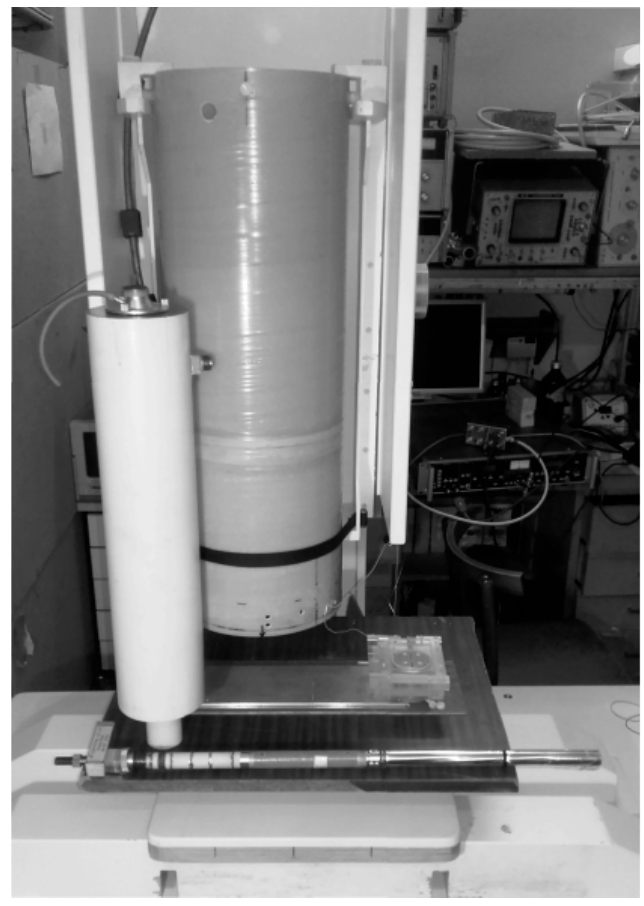
Figure 5. Photograph of a single-channel low-T c DC SQUID-based gradiometer system with a liquid He cryostat and a measurement probe. The first-order gradiometer was made of insulated Nb wire with a diameter of 0.05 mm using a “1:1” configuration (one lower and one upper turn) on a textolite rod. The diameter of the pick-up loops of the gradiometer is 4 mm and the base line of the gradiometer is 40 mm. The initial unbalance of the gradiometer is below 1%. The gradiometer ends are fixed mechanically on the Nb lamella of the SQUID sensor for connection to the SQUID input coil.